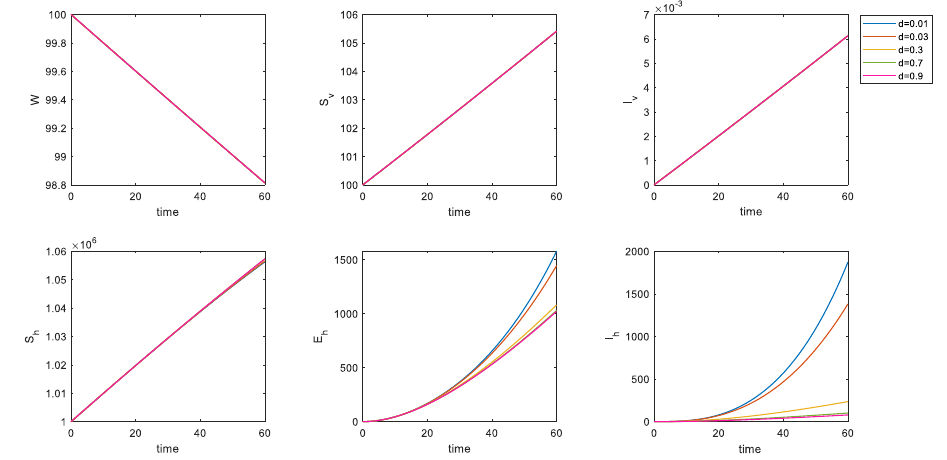
Figure 7. Changes in the numbers of W , S h , E h , and I h with different d in model 2.